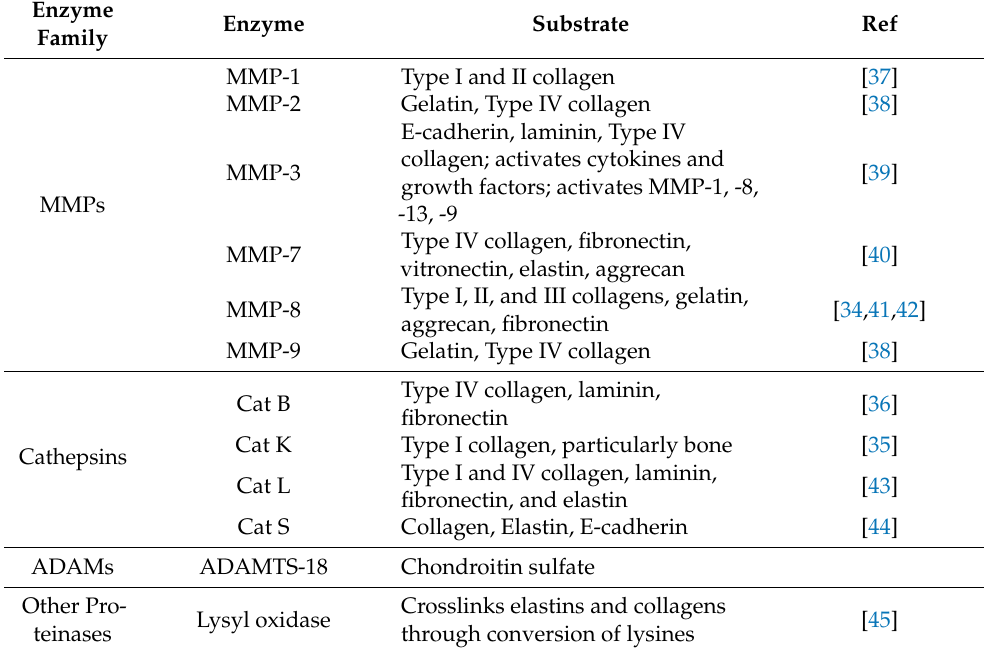
Table 1. Extracellular matrix